Question: Generate an informative caption for the figure above.
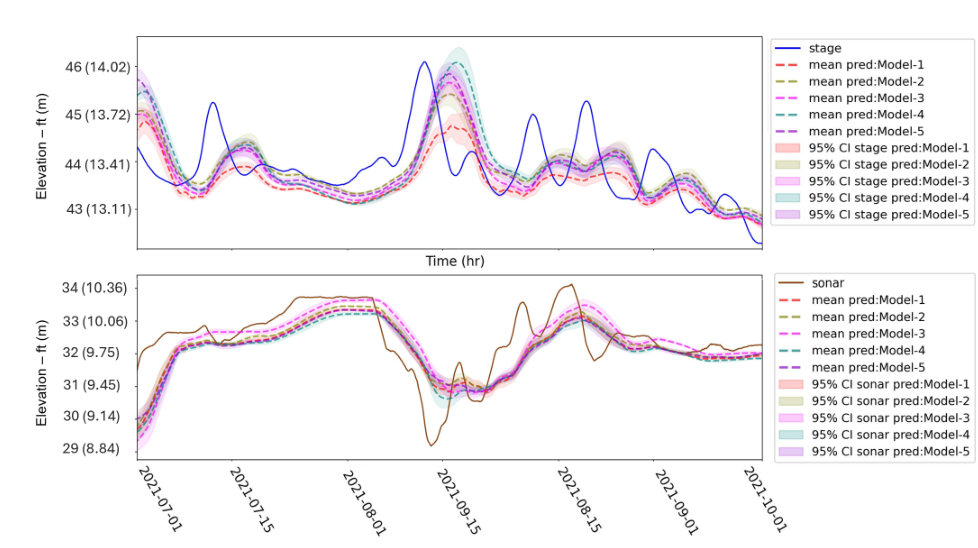
Answer: Stage (top) and Sonar (bottom) predictions of top-5 LSTM models selected by the random-search (meanMAE policy), mean and 95% confidence intervals over the test dataset - Alaska bridge 230.